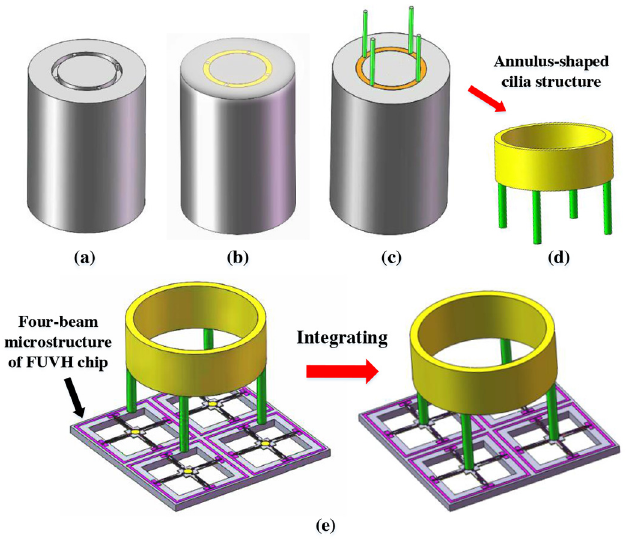
Fig. 15. Integration process of the sensing structure.